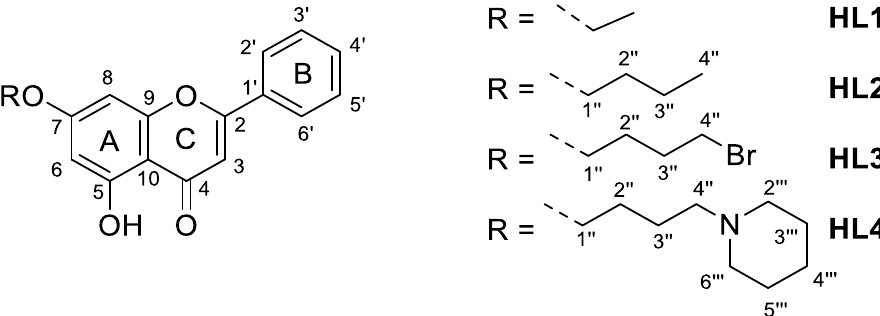
Figure 2. Molecular structure of ligand precursors ( HL1 – HL4 ) and atom numbering scheme.